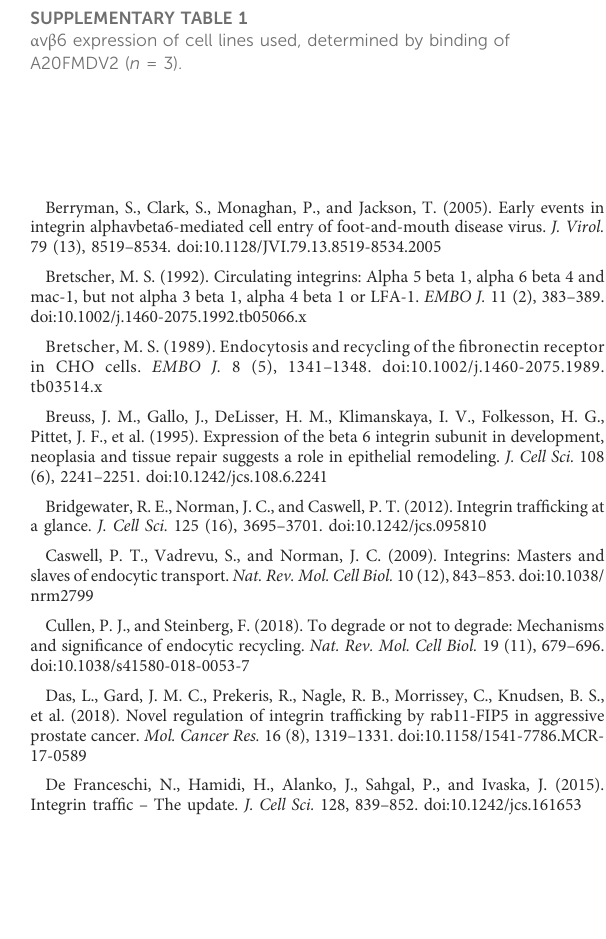
SUPPLEMENTARY FIGURE 1 α v β 6 internalisation in adherent vs. suspension cells. Cells were exposed to A20FMDV2 for 1 h on ice. Unbound peptide was washed away by either centrifugation (suspension cells) or by washing the wells in DMEM 0.1/0.1. Cells were incubated at 37 ° C for 1 h to allow for internalisation, and subsequently acid stripped as previously described. Cells were acquired by fl ow cytometry as described in materials and methods. No signi fi cant differences were observed between the internalisation between cells in suspension vs adhered ( n = 2). SUPPLEMENTARY FIGURE 2 α v β 6 expression (green) in NHBE cells before and after treatment with A20FMDV2. SUPPLEMENTARY FIGURE 3 TCEP concentration optimisations. C76 cells were exposed to Cy5- SS-(GS)5-bioA20FMDV2, and extracellular fl uorescence removed by addition of varying concentrations of TCEP (50, 100, 250, 500 mM). A reduction in both the number of positive cells and relative geometric mean fl uorescence of the cells were observed with each concentration (1.9%, 1.4%, 1.0%, 0%, and 1.38, 1.24, 1.69, 1.61, respectively) compared to control conditions (97% and 14.43). Viability was determined by fl ow cytometry and the uptake of DAPI in to compromised cells. The lowest cell viability was observed with 500nM of TCEP, with only 68% of cells viable, compared with 95% of cells without TCEP [mean values ( n = 2)]. SUPPLEMENTARY FIGURE 4 Western Blot con fi rming knockdown of Clathrin (CLTC) and Caveolin (CAV) Knockdown with siRNA. Relative expression of CLTC in the off target (OT) transfected cells was 0.79 ± 0.2 and 0.29 ± 0.23 in cells transfected with the CLTC smartpool. Relative expression of CAV in the off target (OT) transfected cells was 0.79 ± 0.05 and 0.23 ± 0.28 in cells transfected with the CLTC smartpool. Data are mean ± SD, representative of two biological repeats each with two technical repeats. Representative western blots are shown. SUPPLEMENTARY TABLE 1 α v β 6 expression of cell lines used, determined by binding of A20FMDV2 ( n =